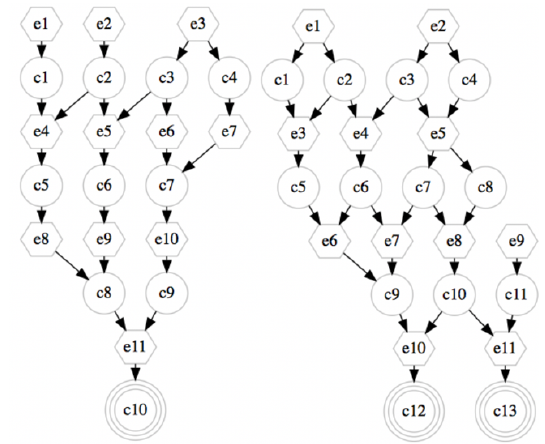
Figure 2. A sample Exploit Dependency graph with a real network (left) and a fake network (right). The above dependency graph for real & fake network H = (N,E) consists of 𝑛 = 10 security conditions, 𝑛 = 11 [ \ ] \ exploits (in the form of hyperedges), 𝑛 = 13 security [ ^ conditions and 𝑛 = 11 exploits respectively. Triple- ] ^ encircled nodes are representing as goal conditions 𝑁 <O = {𝑐 } 𝑎𝑛𝑑 𝑁 QO = {𝑐 , 𝑐 ,I ,- ,a